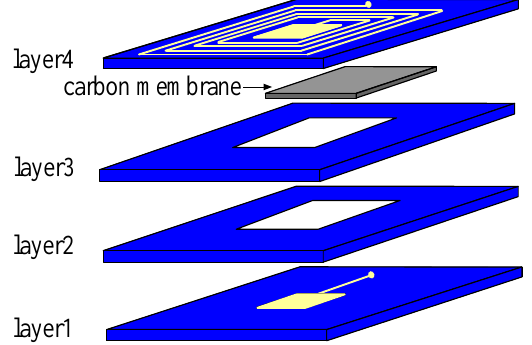
Figure 5. Part of fabrication processes: Stack cutted and metallized layers include layer 1, layer 2 and layer 3 successively and place carbon membrane in the cavity. Then stack layer 4 on the layer 3.